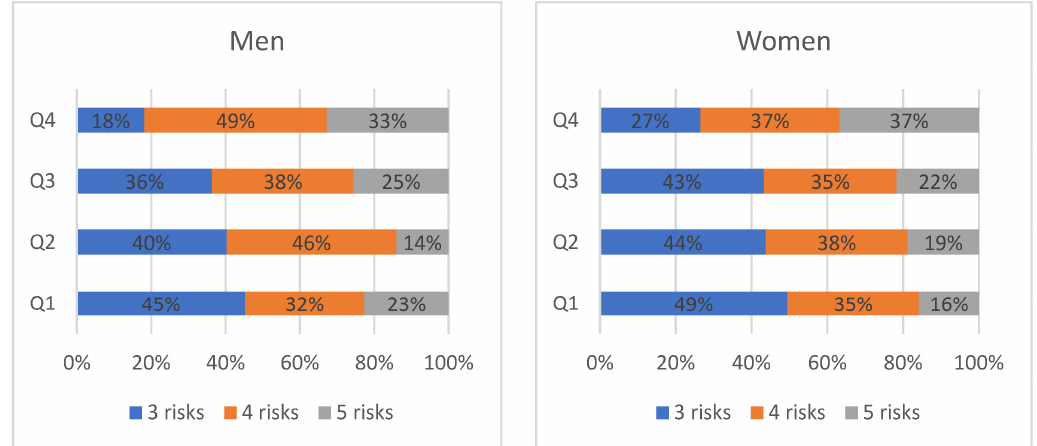
Figure 2. Proportions of metabolic syndrome risk number gathered in each quartile (%) for men and women.